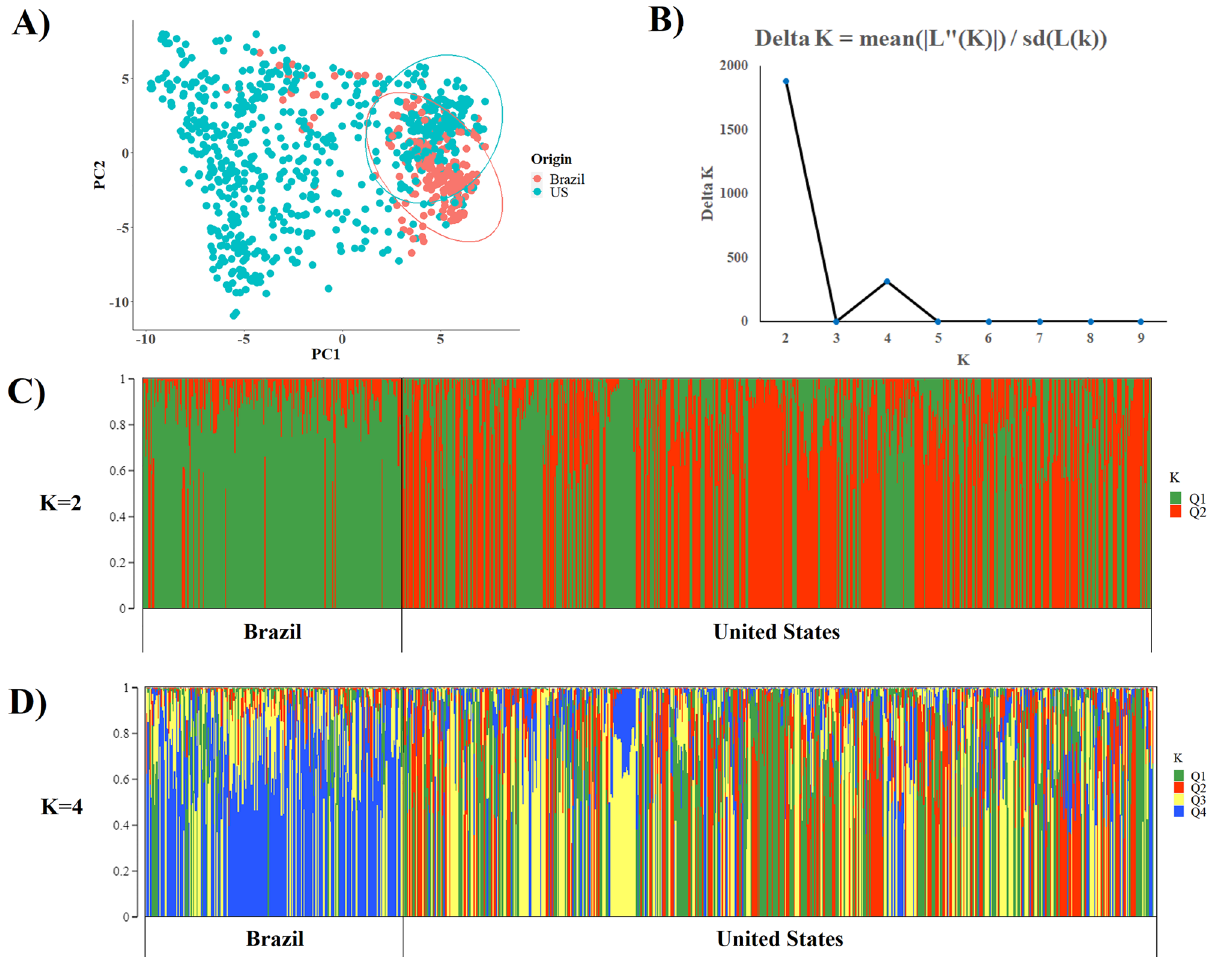
Figure 1. Population structure analysis between Brazilian and US germplasms. ( A ) Principal component analysis of Brazilian and US soybean cultivars based on SNPs markers; (B ) Delta K as a function of the number of groups (K); ( C ) assignment coefficients of individual cultivars (bar plots) considering K = 2; and ( D ) considering K =